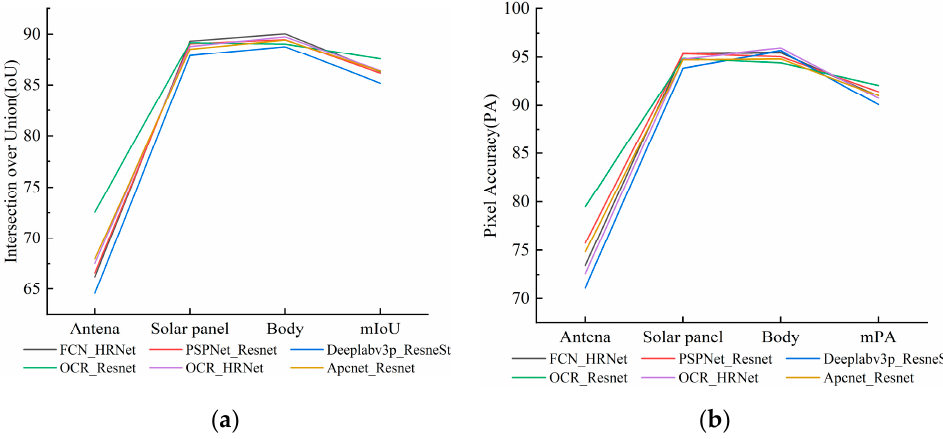
Figure 14. Various types of accuracy and overall accuracy obtained by training and validation of the mixed dataset: ( a ) intersection over union; ( b ) pixel accuracy.